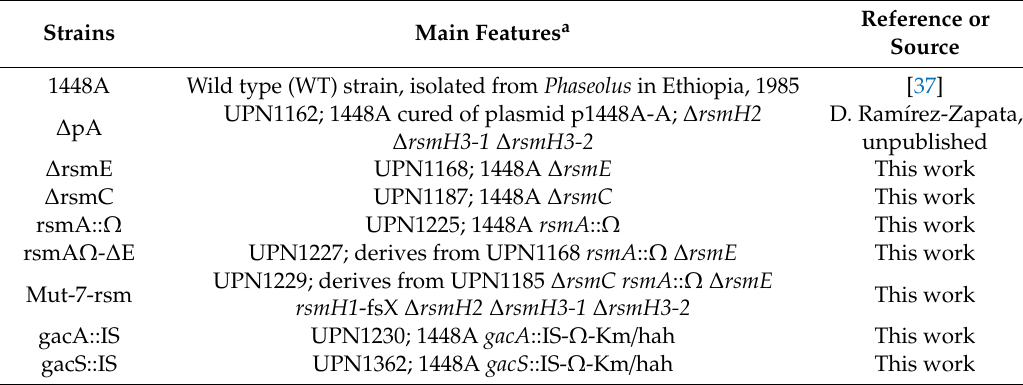
Table 1. Relevant Pseudomonas amygdali pv. phaseolicola strains used in this